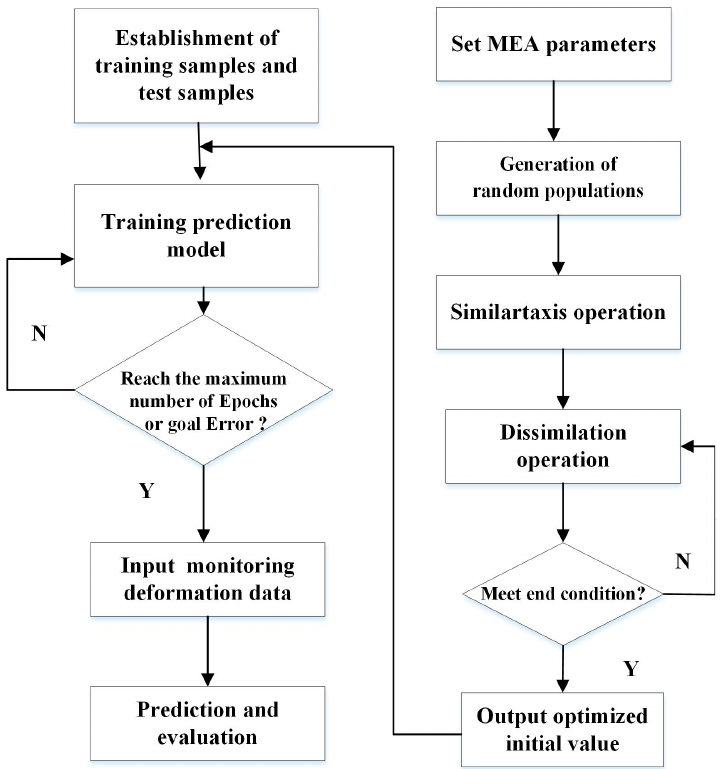
Figure 4. The flow chart of the MEA-BP prediction model.